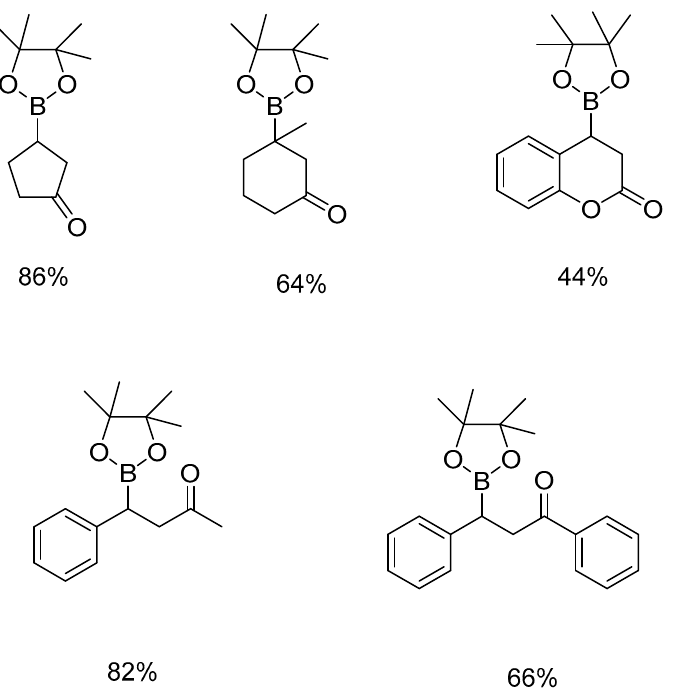
Figure 4. Scope of Cu 3 (BTC) 2 for the β -boronation of various α , β -unsaturated substrates. The per- centage yields of these products correspond to the GC yield. Reaction Conditions: enone (0.5 mmol), B 2 pin 2 (0.5 mmol), Cs 2 CO 3 (0.12 mmol), Cu 3 (BTC) 2 (40 mg), CH 3 CN (2 mL), 60 ◦ C, 6